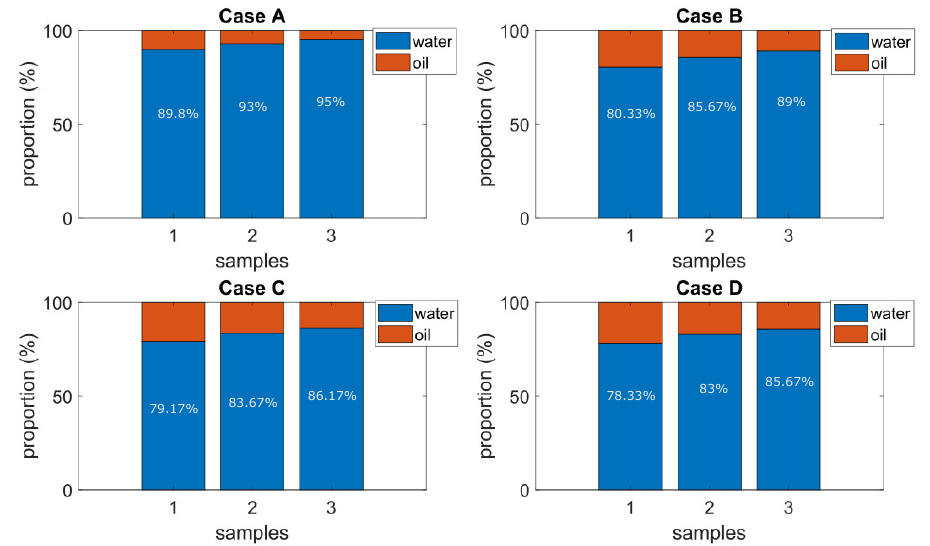
Figure 13. Samples from the bottom layer at t = 10 min (Sample 1), t = 20 min (Sample 2), and t = 30 min (Sample 3) after